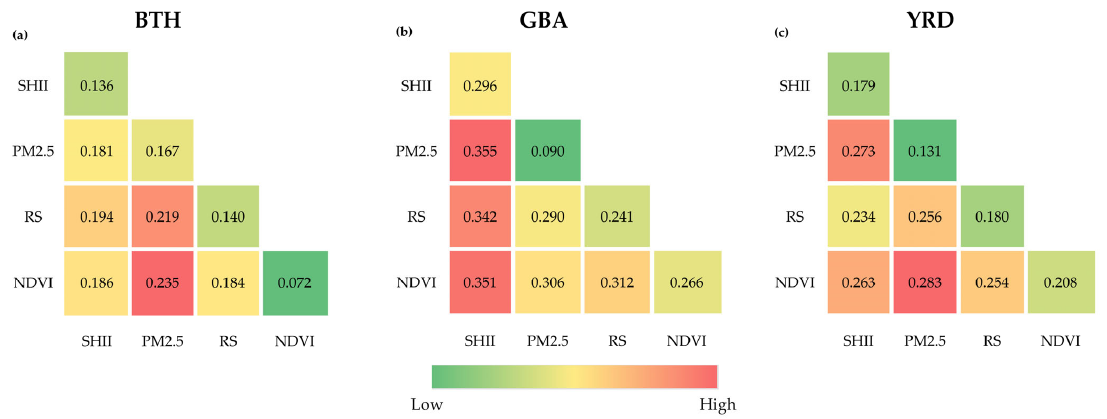
Figure 15. Interactive influences of different environmental situations on habitat quality: ( a ) BTH, ( b ) GBA, and ( c ) YRD.